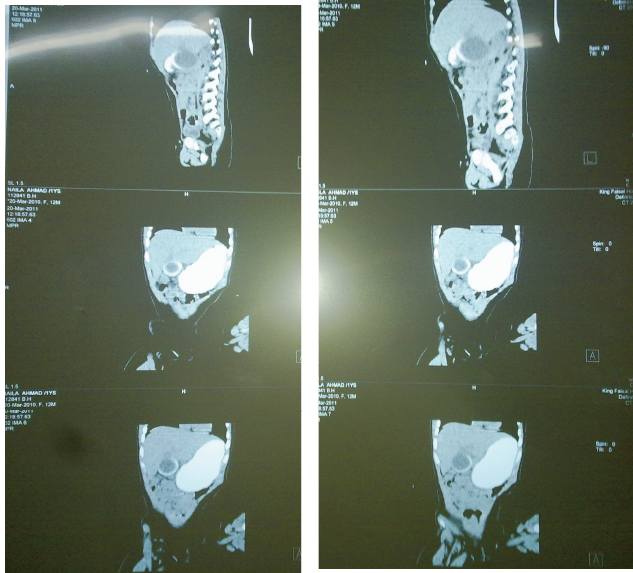
Figure 4 : Magnetic Resonance Cholangiopancreatography (MRCP) showing multi-echoic, multiplanar images through the upper abdomen with evidence of a large well-defined fluid intensity signal cystic lesion in the right abdomen measuring 3 × 3.3 × 3.4